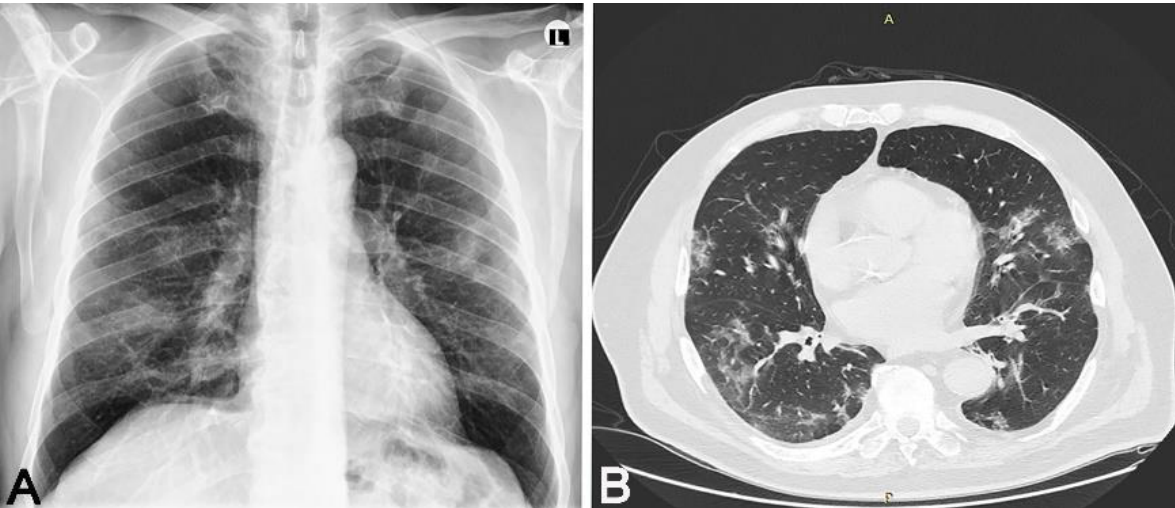
Figure 1. Thirty-eight-year-old male patient without any chronic diseases was admitted to the emergency department as a SARS-CoV-2 positive with high fever, cough, dyspnea and fatigue. Chest X-ray showed ( A ) bilaterally gentle inhomogeneous shading initial infiltrative changes. After 9 days from the onset of infection, dyspnea worsened, chest MSCT showed ( B ) areas of enhanced attenuation by the type of ground glass, and patchy consolidations are seen on both sides. The patient developed bilateral pneumonia. Legend: L — left side, small A letter on panel B: A — anterior, P — posterior.